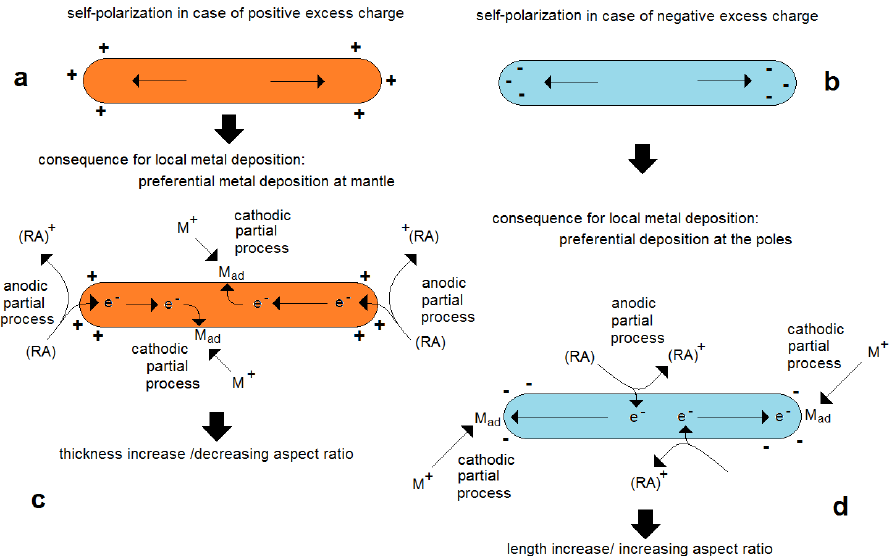
Figure 3. Effect of self-polarization on the evolution of particle shape; example of a growing metal nanorod. positive charges are pushed into direction of the poles of the metal nanorod in case of a positive excess charge ( a ) causing the preferential oxidation of reducing agent molecules (RA) at the particle poles ( c ); negative charges are pushed into direction of the poles of the metal nanorod in case of a negative excess charge ( b ) causing the preferential reduction of positively charged metal ions causing the deposition of metal (0) at the particle poles ( d ).